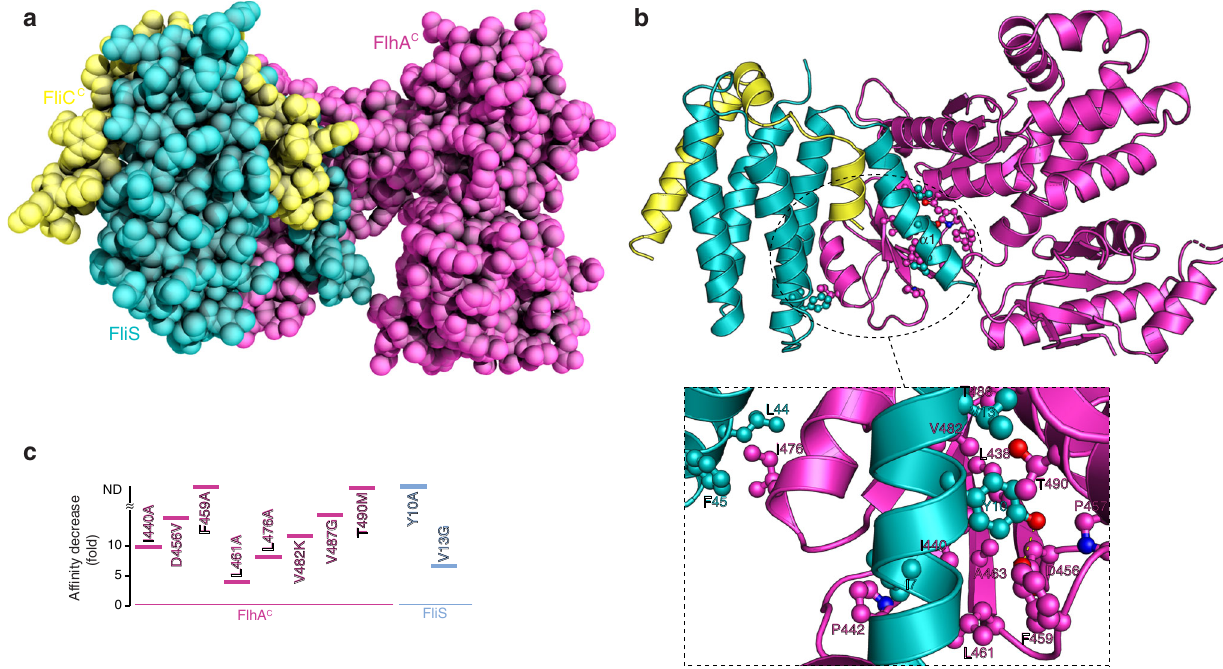
Fig. 4 Structure of the FlhA C − FliS − FliC C ternary complex. a Crystal structure of the ternary complex shown as a space- fi lling model. b Cartoon rendering of the structure and expanded view of the interacting regions between FlhA C and FliT. Residues participating in intermolecular contacts are shown as ball- and-stick. Hydrogen bond is shown as broken lines. c Effect of the indicated amino acid substitutions on the af fi nity of FlhA C for FliS − FliC C . The effect is given as a fold decrease relative to the af fi nity of the wild-type proteins ( K d ~10 μ M; Supplementary Fig. 5d). Non-detected binding is indicated as